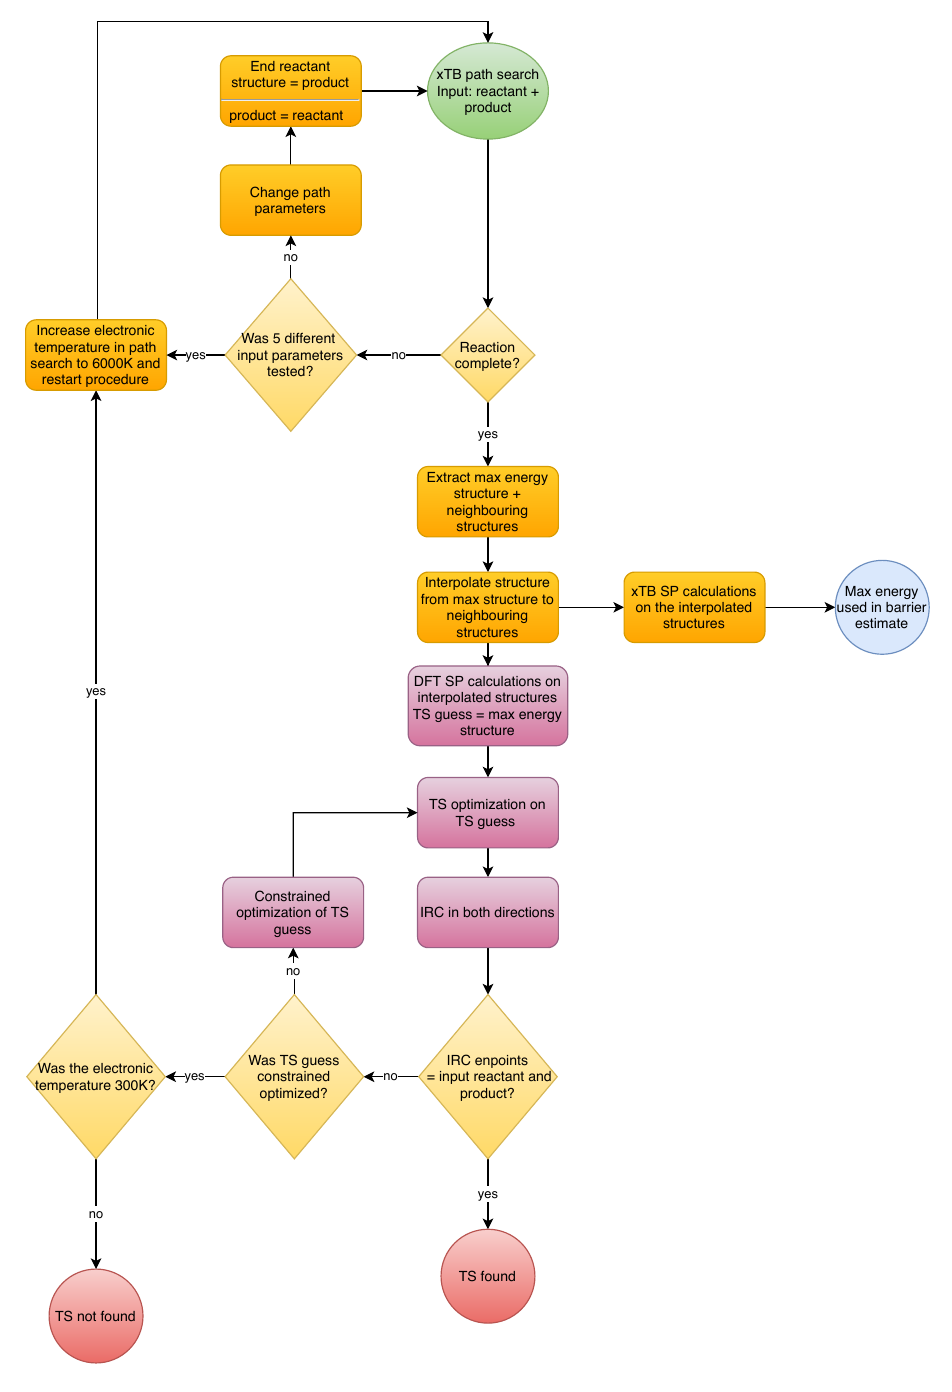
Figure 1 Flowchart describing the automated workflow implemented. Orange steps depend solely on GFN2-xTB calculations, while purple steps rely on DFT calculations. Full-size DOI: 10.7717/peerjpchem.15/fig-1